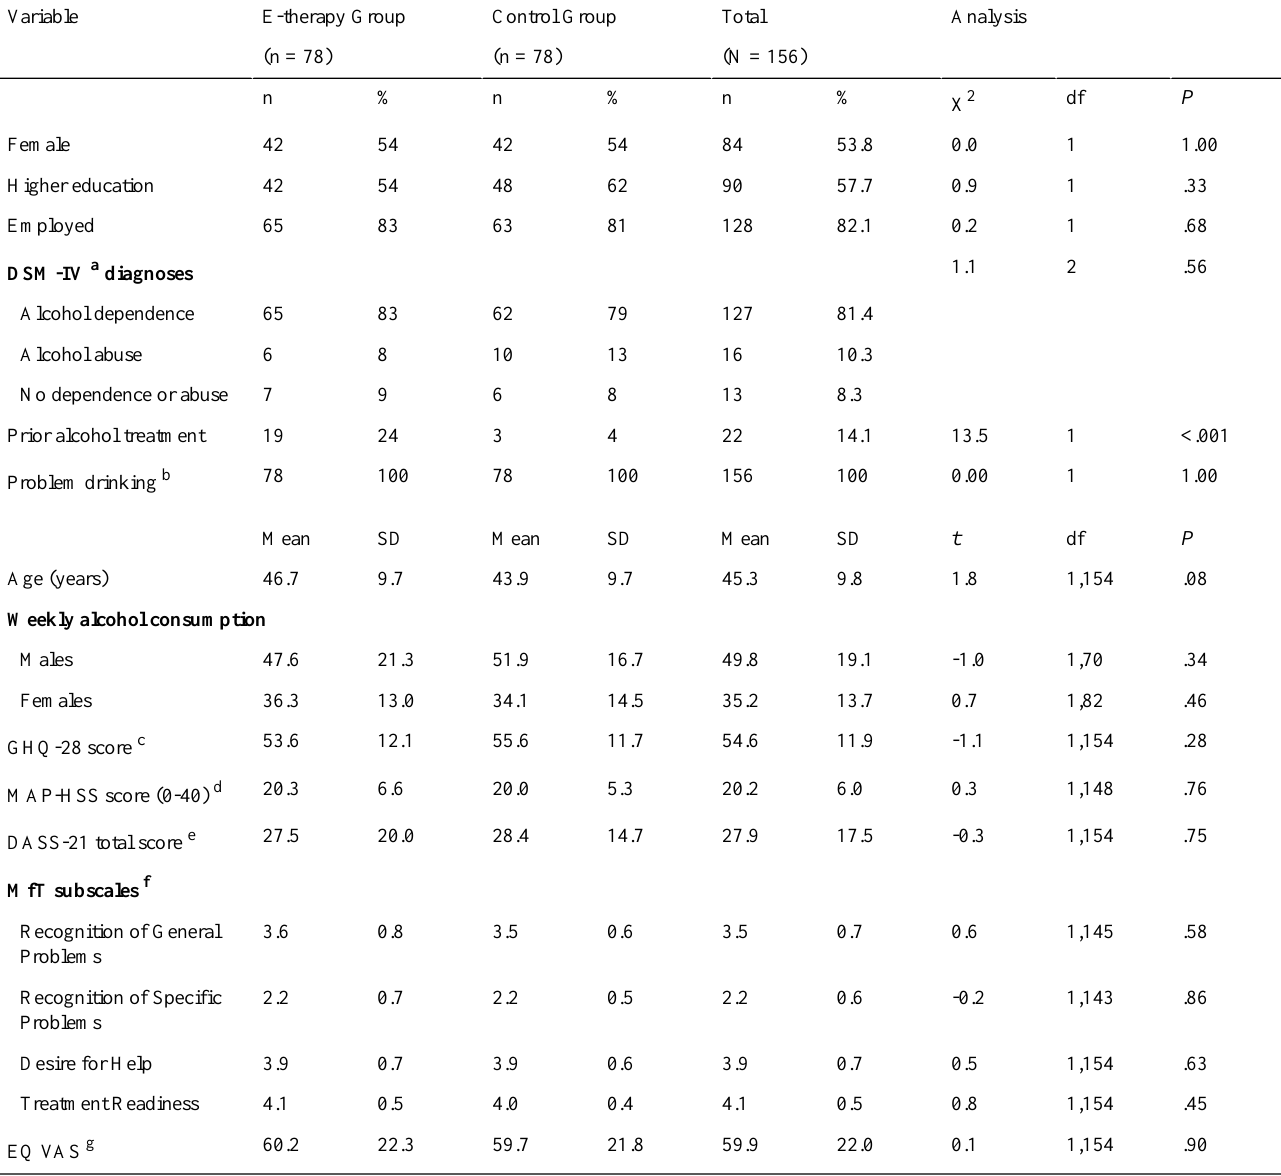
Table 1. Baseline characteristics of test populations